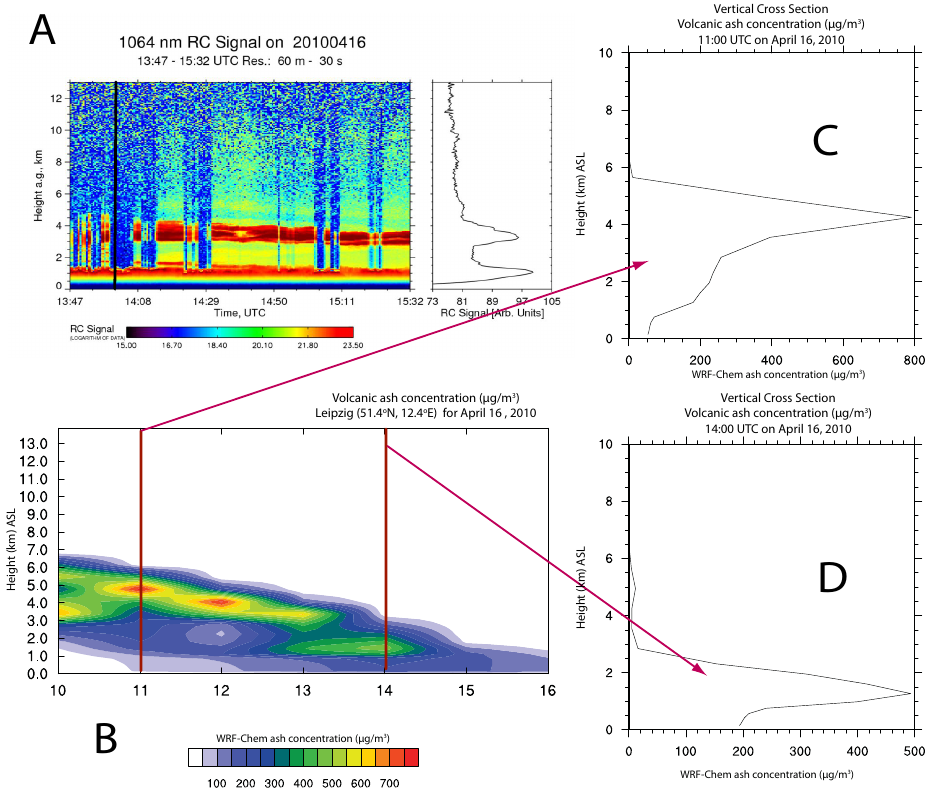
Fig. 6. (A) Earlinet lidar at Leipzig, Germany, showing the evolution of the major ash plume over Leipzig on 16 April 2010 (in red, 3–5km height, 13:47–15:32UTC) in terms of 1064nm range-corrected (RC) lidar signal (arbitrary units), (B) WRF-Chem simulation from 10:00 to 16:00UTC, and (C, D) vertical profiles at 11:00 and 14:00UTC, respectively (adapted from Webley et al.,